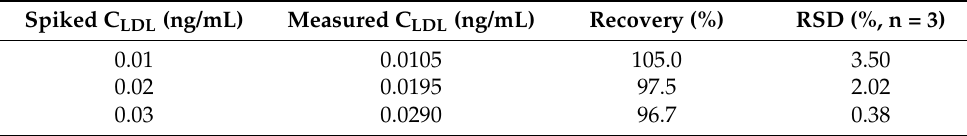
Table 2. Results of LDL detection in human serum samples. Spiked C LDL